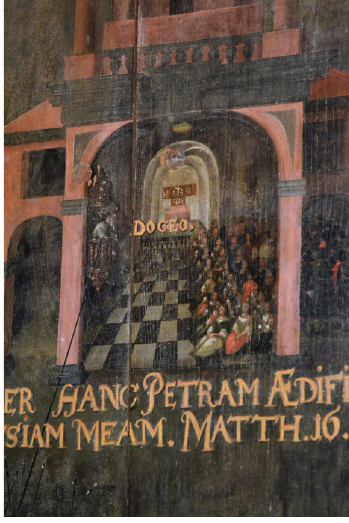
Figure 15 The pastor: